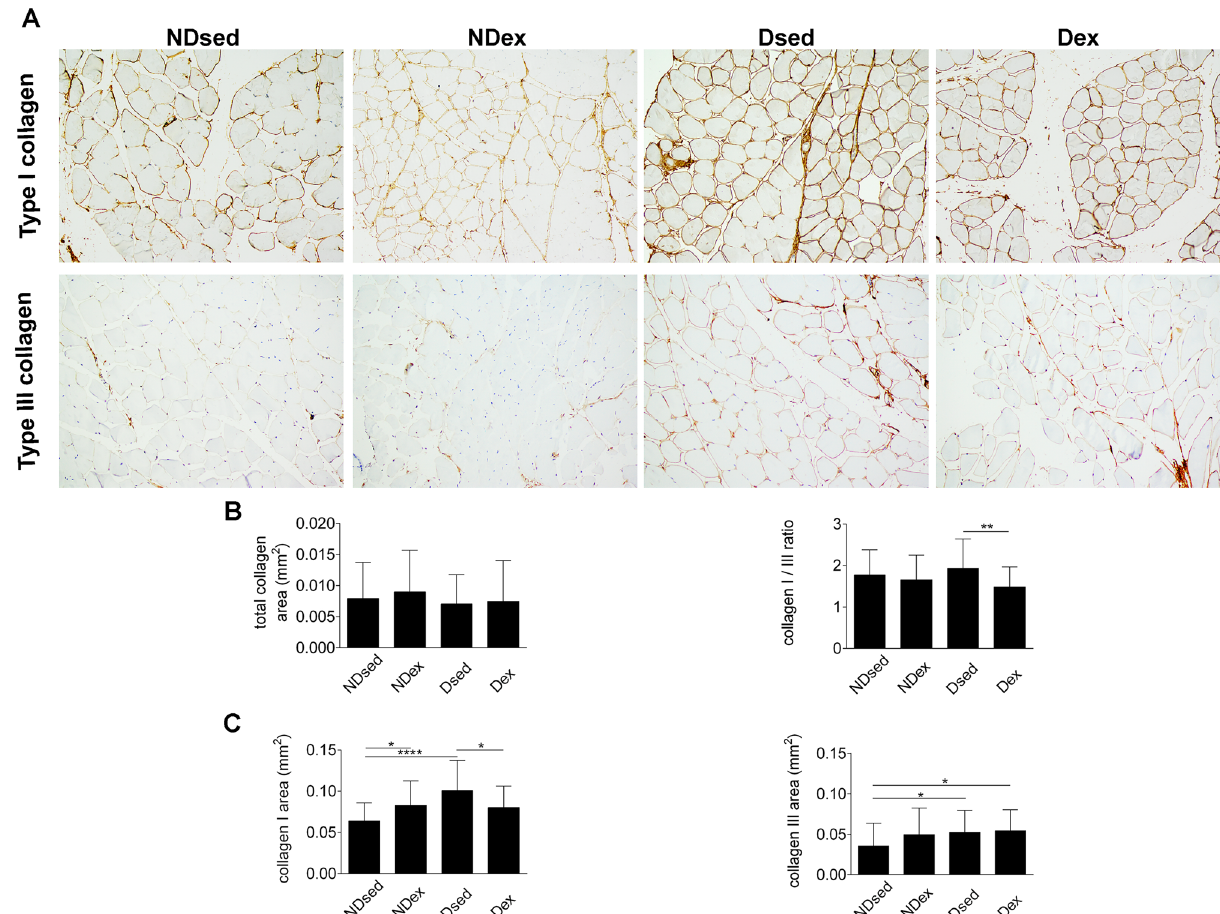
Figure 3. Immunohistochemical sections of rat rectus abdominis muscle (RAM), obtained from CellSens Dimension (Olympus Corporation ® ) Version 1.16 image analysis software—(https:// www. olymp us- lifes cience. com/ en/ softw are/ cells ens/). ( A ) RAM samples were taken from non-diabetic sedentary (NDsed), non-diabetic exercised (NDex), diabetic sedentary (Dsed) and diabetic exercised (Dex) rats as described in Materials and methods. RAM samples were stained with Picrosirius red and immunohistochemistry using antibodies against type I and III collagen on RAM fibers. (B) Picrosirius red staining for total collagen area and immunohistochemistry for type I/III ratio. ( C ) Immunohistochemistry for type I and III collagen area as in ( A ). Values are means ± S.D. (n = 5 animals/group. *p < 0.05, **p < 0.01, ***p < 0.001 and ****p < 0.0001. Scale bar: 50 µm. Magnification: